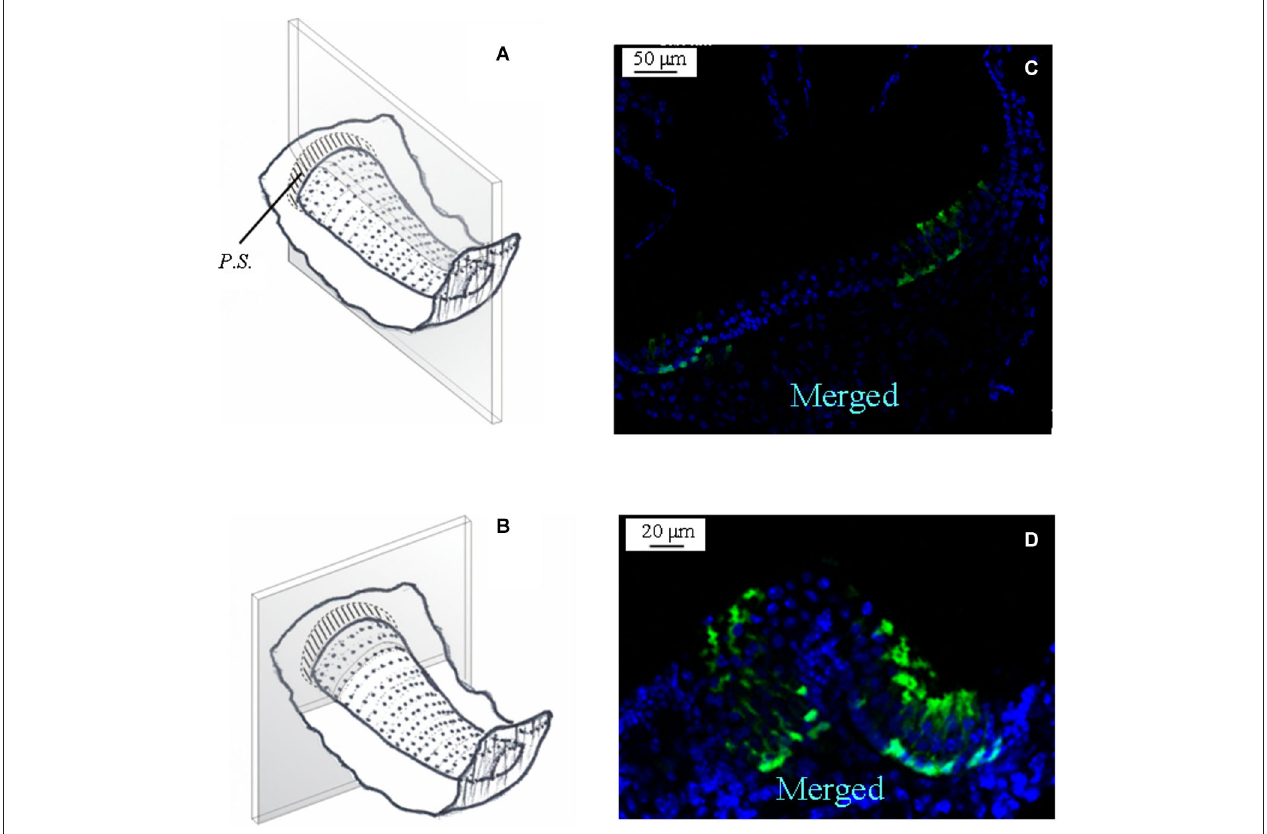
FIGURE 5 | GAD67 expression in the mouse horizontal crista . (A,B) Schematic representations showing the plane of the longitudinal and transverse sections shown in (C) and (D) . Note the absence, also in the horizontal crista, of GAD67 expression in the central zone of the sensory